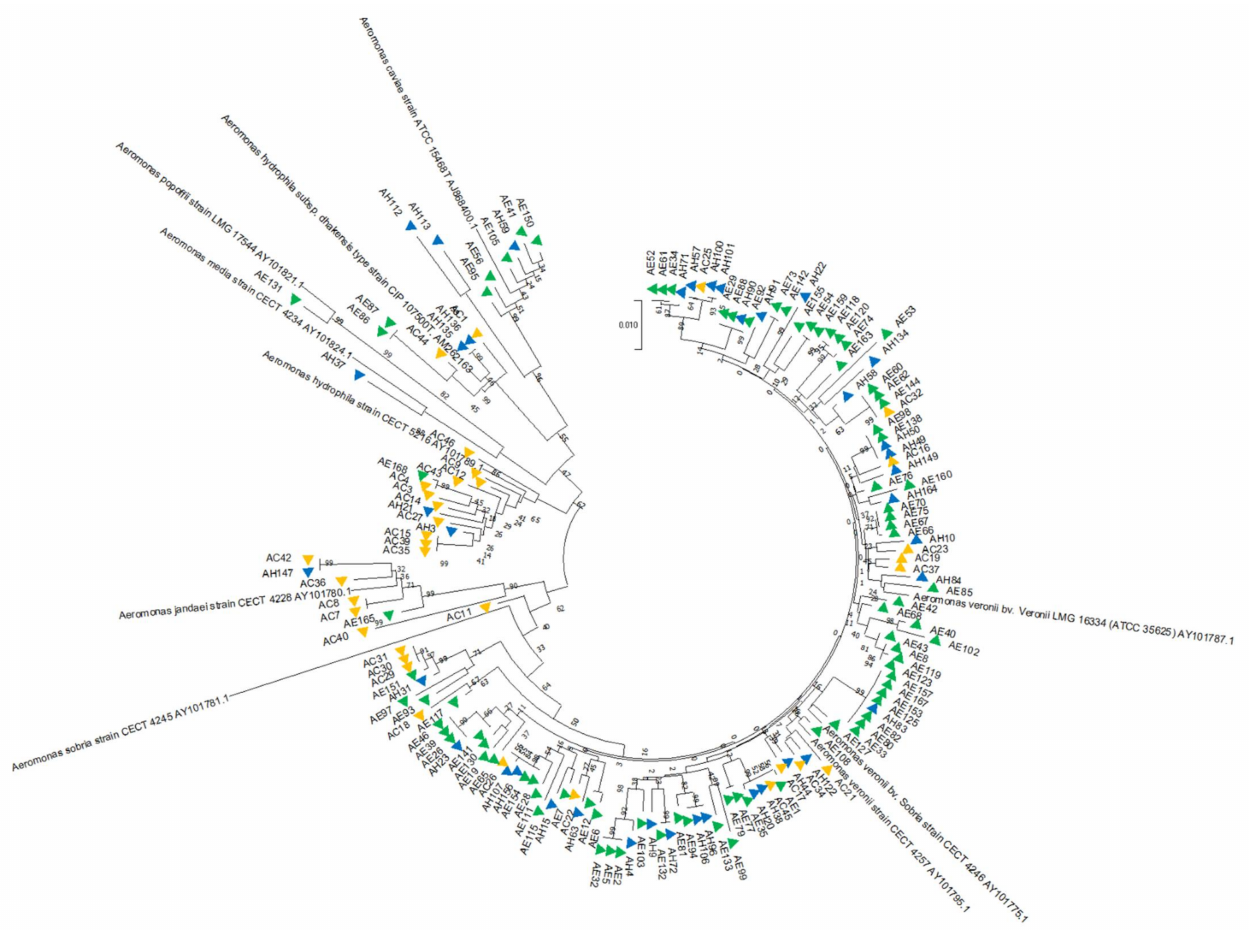
Figure 2. Phylogenetic tree of Aeromonas spp. based on gyrB sequences using neighbor-joining method with bootstrap replication with 1000. AE: Aeromonads isolated from environment; AH: aeromonads isolated from healthy fish; AC: aeromonads isolated from diseased ornamental fish. The color of triangle next to the isolate name represents the source of isolation; green—environmental, blue—healthy ornamental fish, yellow—diseased ornamental